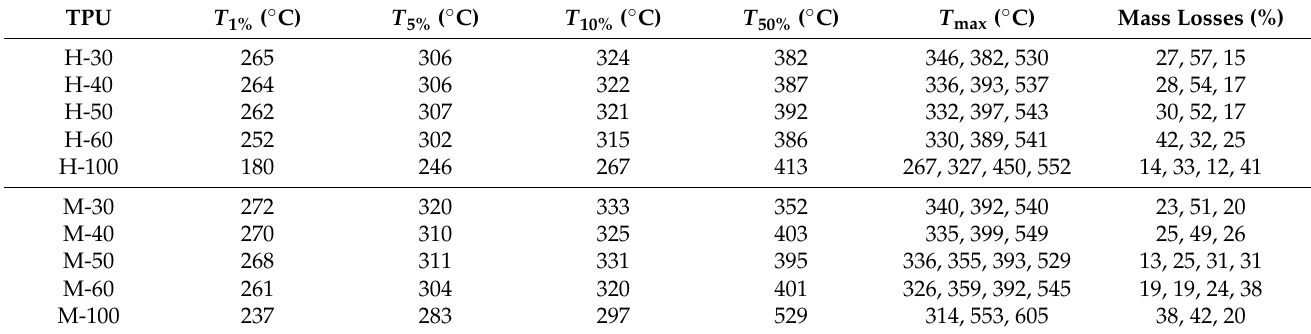
Table 2. TG-DTG data obtained for TPUs in the synthetic air